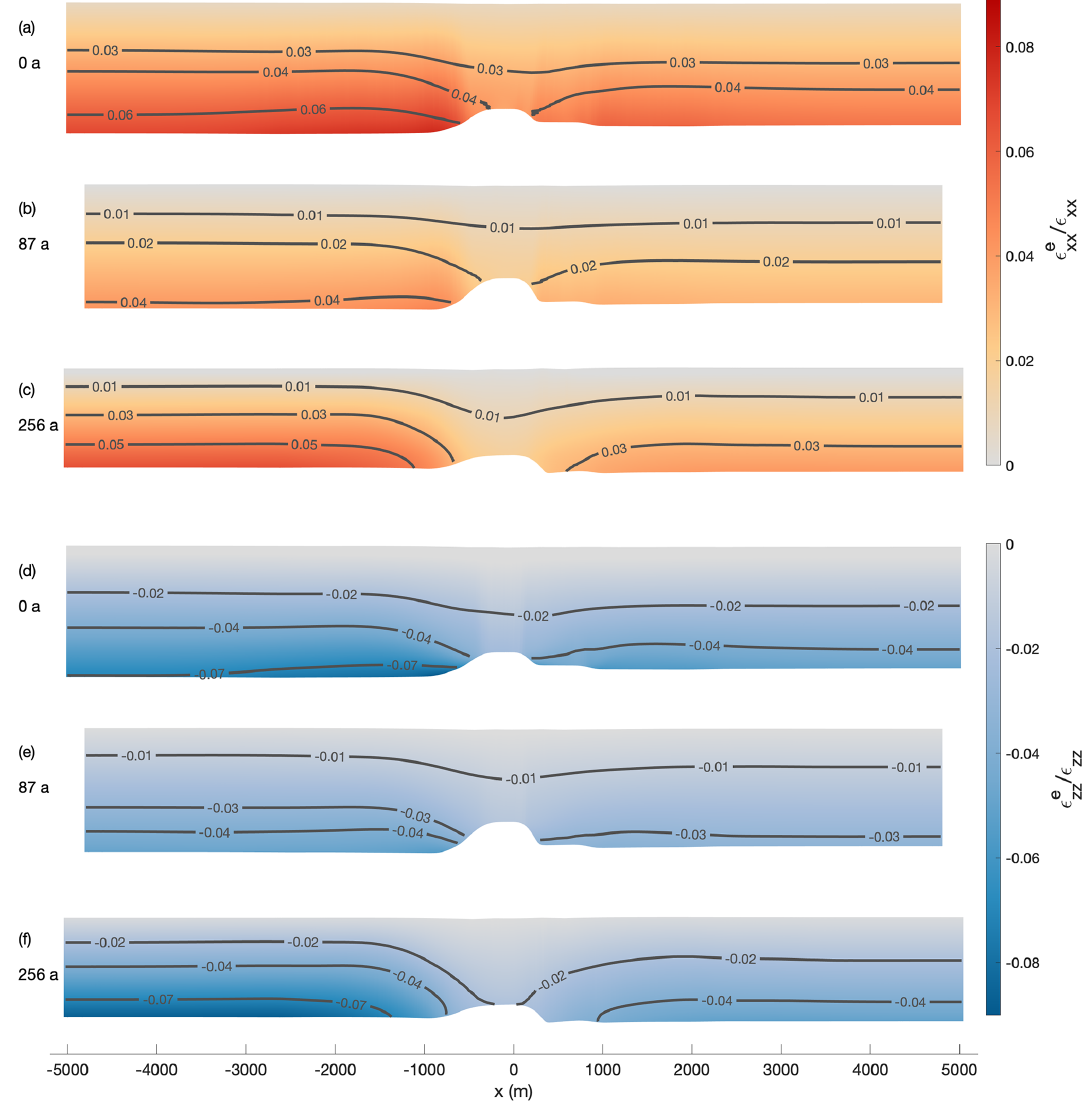
Figure B12. Relative contribution of elastic to total strain of the second experiment using synthetic melt rates for the simulation. The upper three panels show the relative elastic strain in the across-flow direction (cid:15) e xx /(cid:15) xx for (a) t = 0 year (after the spin-up, maximum lateral compression), (b) t = 87 years (small lateral displacement) and (c) t = 256 years (end of the simulation). The lower three panels show the relative elastic strain in the thickness direction (cid:15) e zz /(cid:15) zz for (d) t = 0 year (after the spin-up, maximum lateral compression), (e) t = 87 years (small lateral displacement) and (f) t = 256 years (end of the simulation). The negative values denote that the elastic and viscous strains have different signs. The elastic and viscous Hencky strain sum up to the total